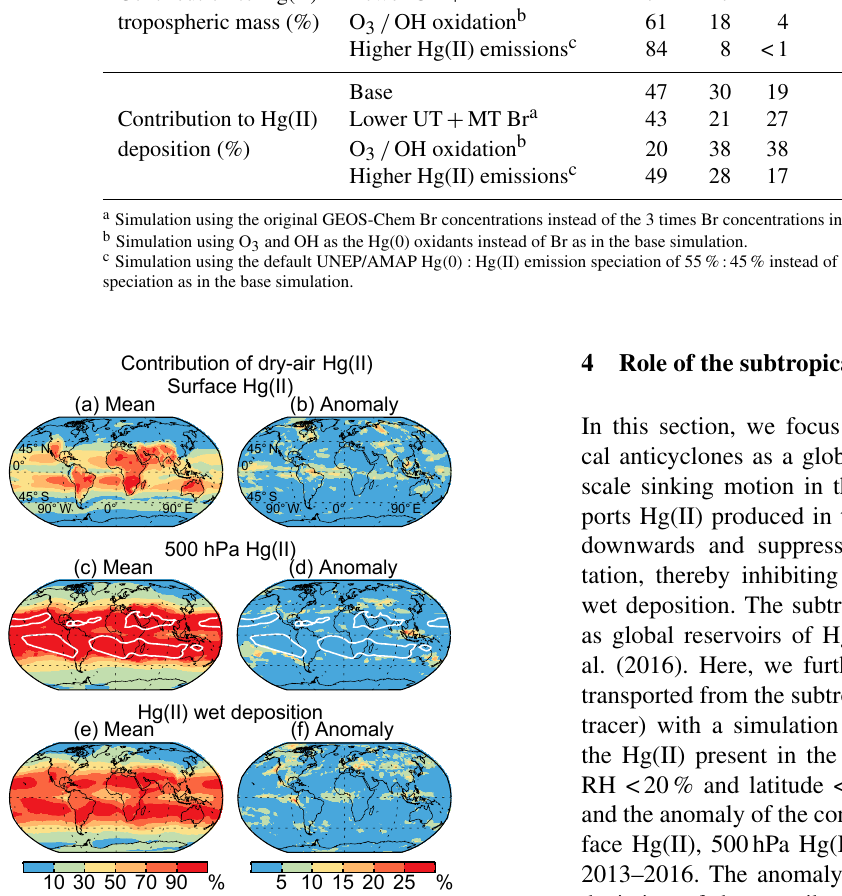
Figure 7. Mean and anomaly (maximum deviation from the mean) of the contributions of dry-air Hg(II) to (a, b) surface Hg(II) concen- trations, (c, d) 500hPa Hg(II) concentrations, and (e, f) Hg(II) wet deposition flux for 2013–2016. The white contours in (c, d) show the boundaries at 500hPa for areas with RH less than 20% for a minimum of 4 months of the